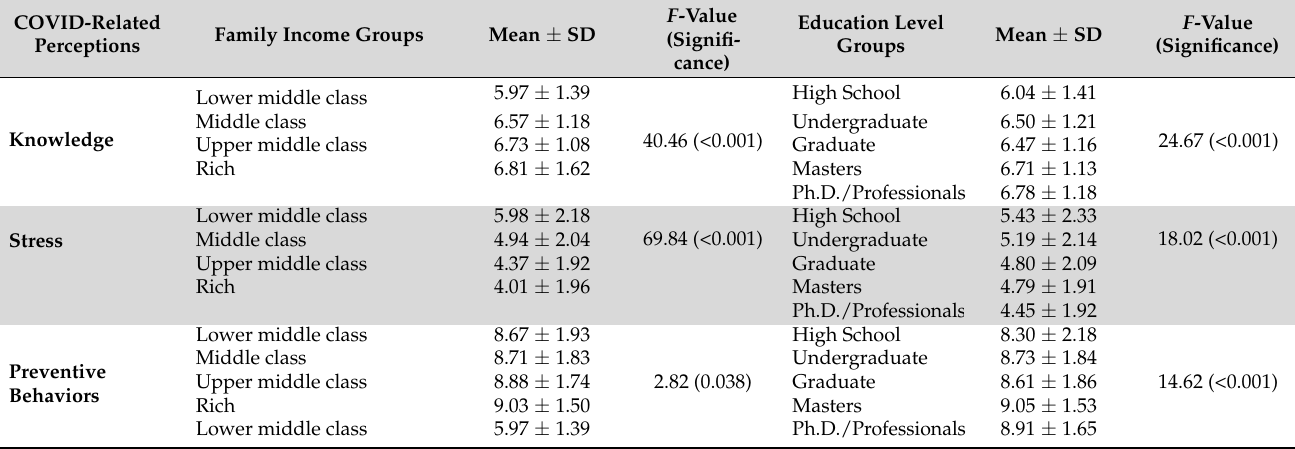
Figure 1. Box-plot representing differences in preventive behaviors, knowledge, and stress among different groups categorized based on education level, family income, race, and age. Table 3. The difference in preventive behaviors, knowledge, and stress among various groups categorized based on family income and education level. The level of significance was estimated by